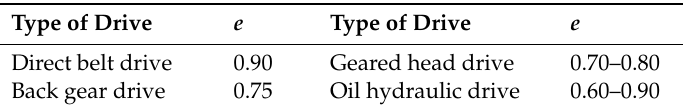
Table 1. e , Machine tool e ffi ciency factor